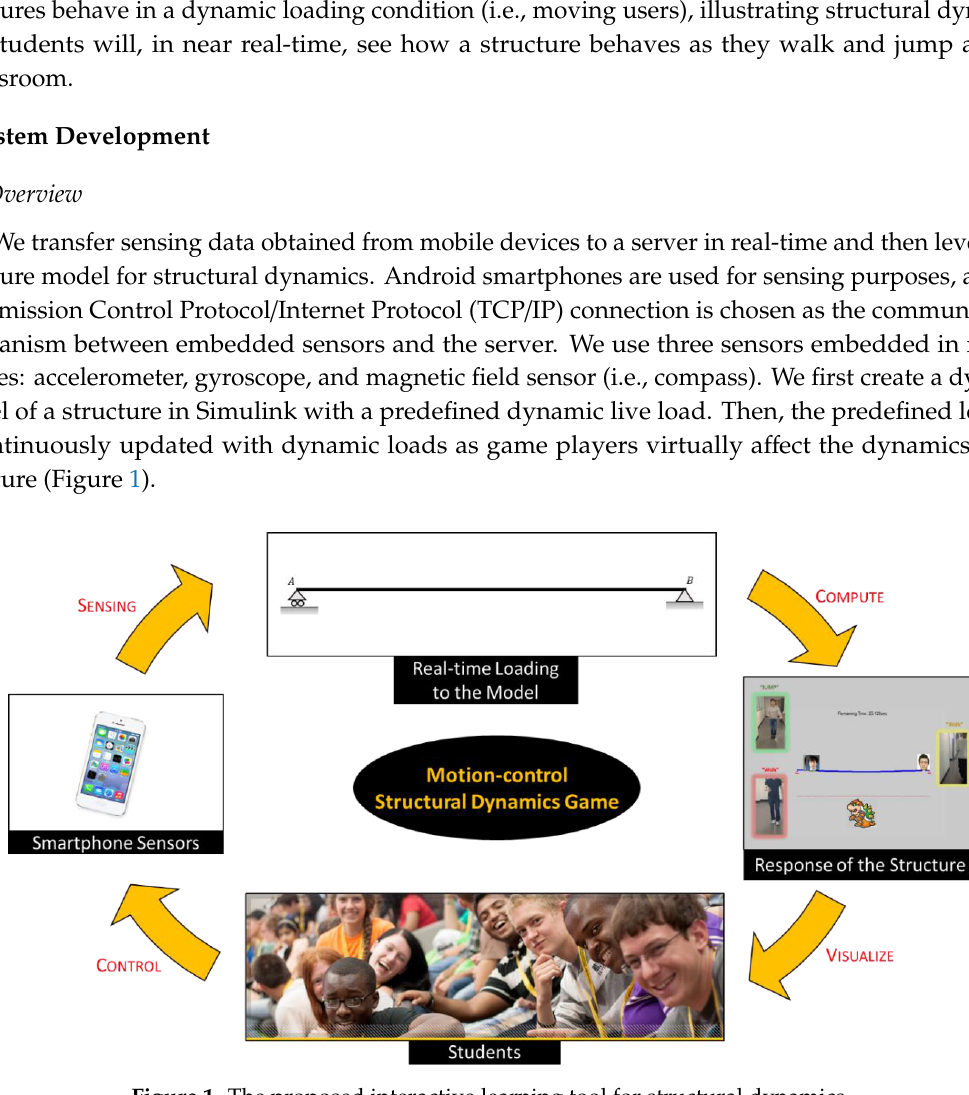
Figure 1. The proposed interactive learning tool for structural dynamics.